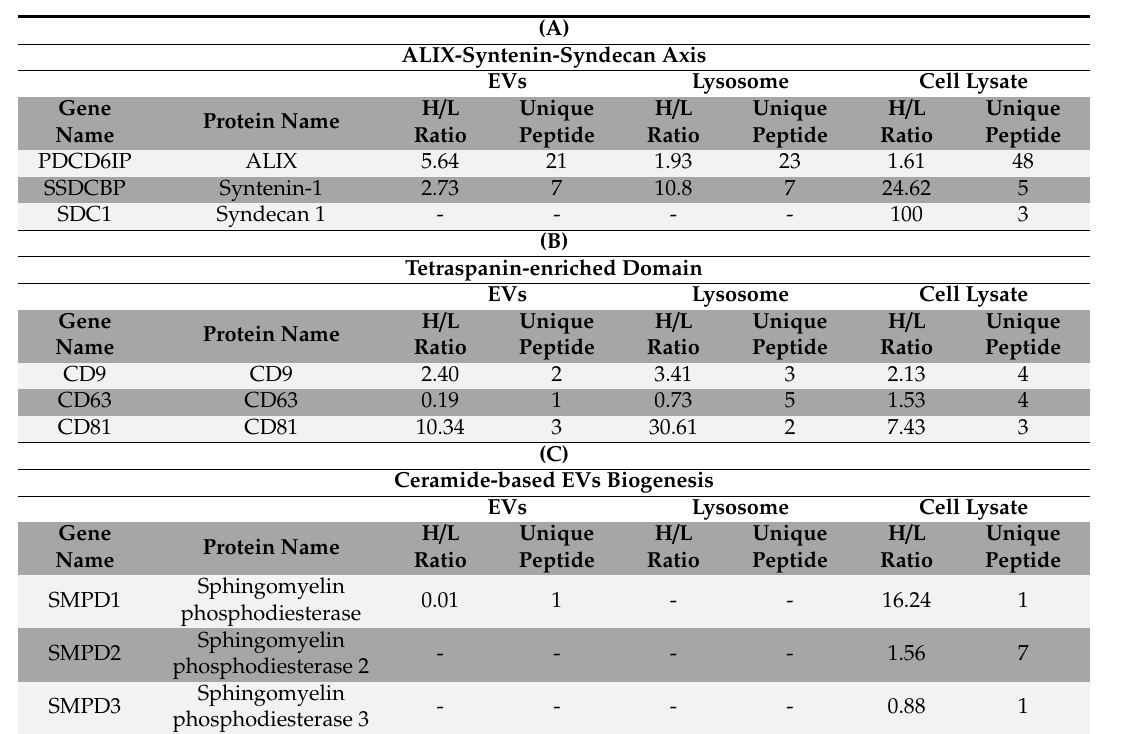
Table 3. H // L analysis of ESCRT dependent and independent mechanism for MVBs formation. The ALIX-syntenin-syndecan ( A ), tetraspanins-enriched domain ( B ) and ceramide-based EVs biogenesis ( C ) are alternate mode of MVBs